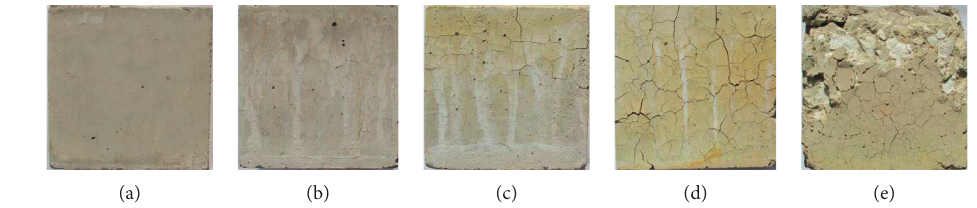
Figure 7: Typical pictures of the DSRR-0% specimen after elevated temperature. (a) 100 ° C. (b) 300 ° C. (c) 500 ° C. (d) 700 ° C. (e) 900 ° C.